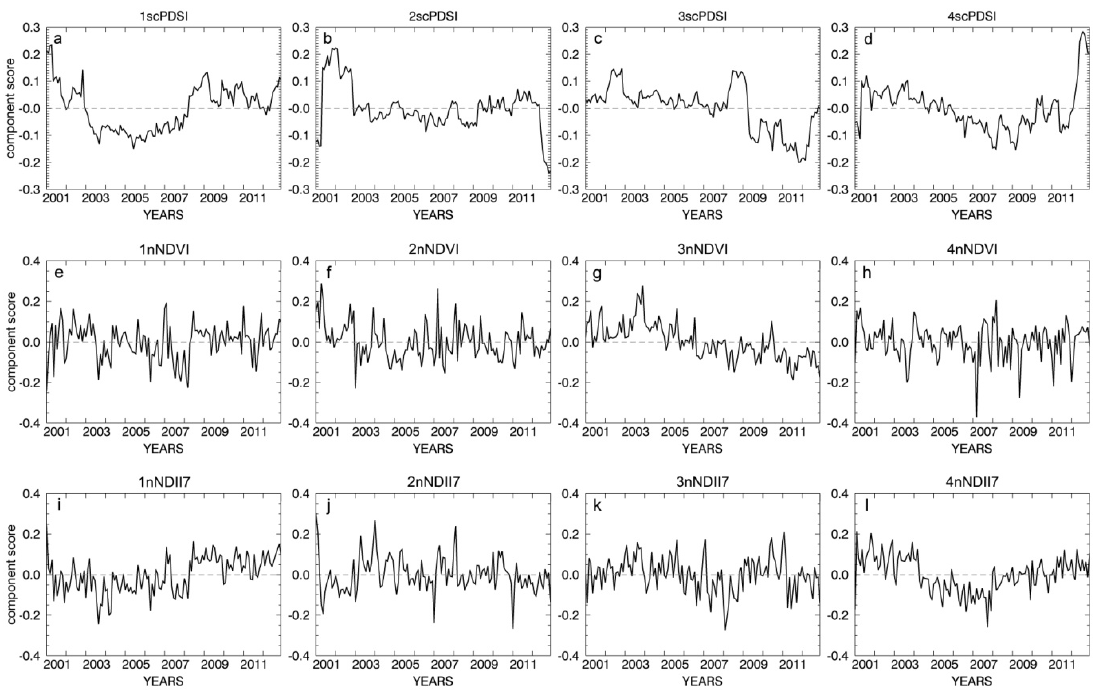
Figure 1. Principal components showing 2001–2012 drought related variability. Top row: meteorological drought conditions approximated by the first four PCs from correlation-matrix based PCA of the 2001–2012 scPDSI time series consolidated for 26 meteorological stations. Scores 1st to 4th correspond with panels ( a – d ), and accounted for 63%, 9.95%, 7.36% and 5.61% of the total scPDSI data variance, respectively. Middle row: changes in forest canopy photosynthetic activity (‘greenness’) rendered in the first four PCs from covariance-matrix based PCA of the nNDVI (z-score normalized vegetation season NDVI) time series. PCs are presented in increasing order on panels ( e – h ). They explained 15.25%, 5.65%, 3.37% and 2.28% of the total nNDVI time series variance, respectively. Bottom row: variability in forest canopy foliage water content captured in the first four PCs of covariance-matrix based PCA of the nNDII7 (z-score normalized vegetation season NDII7) time series. Panels ( i – l ) depict PCs 1st to 4th that accounted for 11.98%, 3.39%, 2.23% and 1.66% of the total nNDII7 time series variance, respectively. Figure modified from [60].